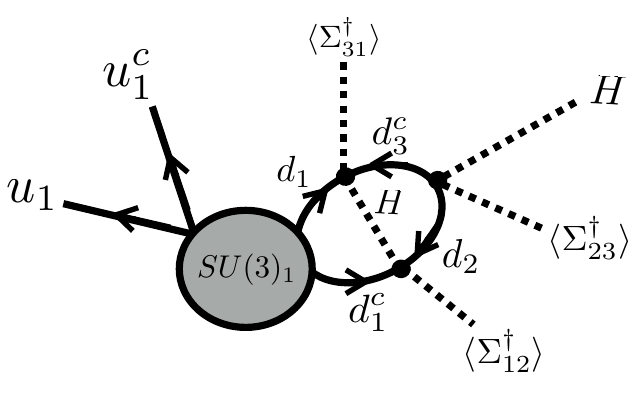
Figure 6 . One of the leading diagrams generating a non-vanishing threshold correction to (cid:1)(cid:22) (cid:18) . The o(cid:11)-diagonal Yukawa couplings appear in order to introduce a CP phase, and the instanton violates the anomalous PQ symmetry protecting the UV form of the Yukawa couplings as in eq.